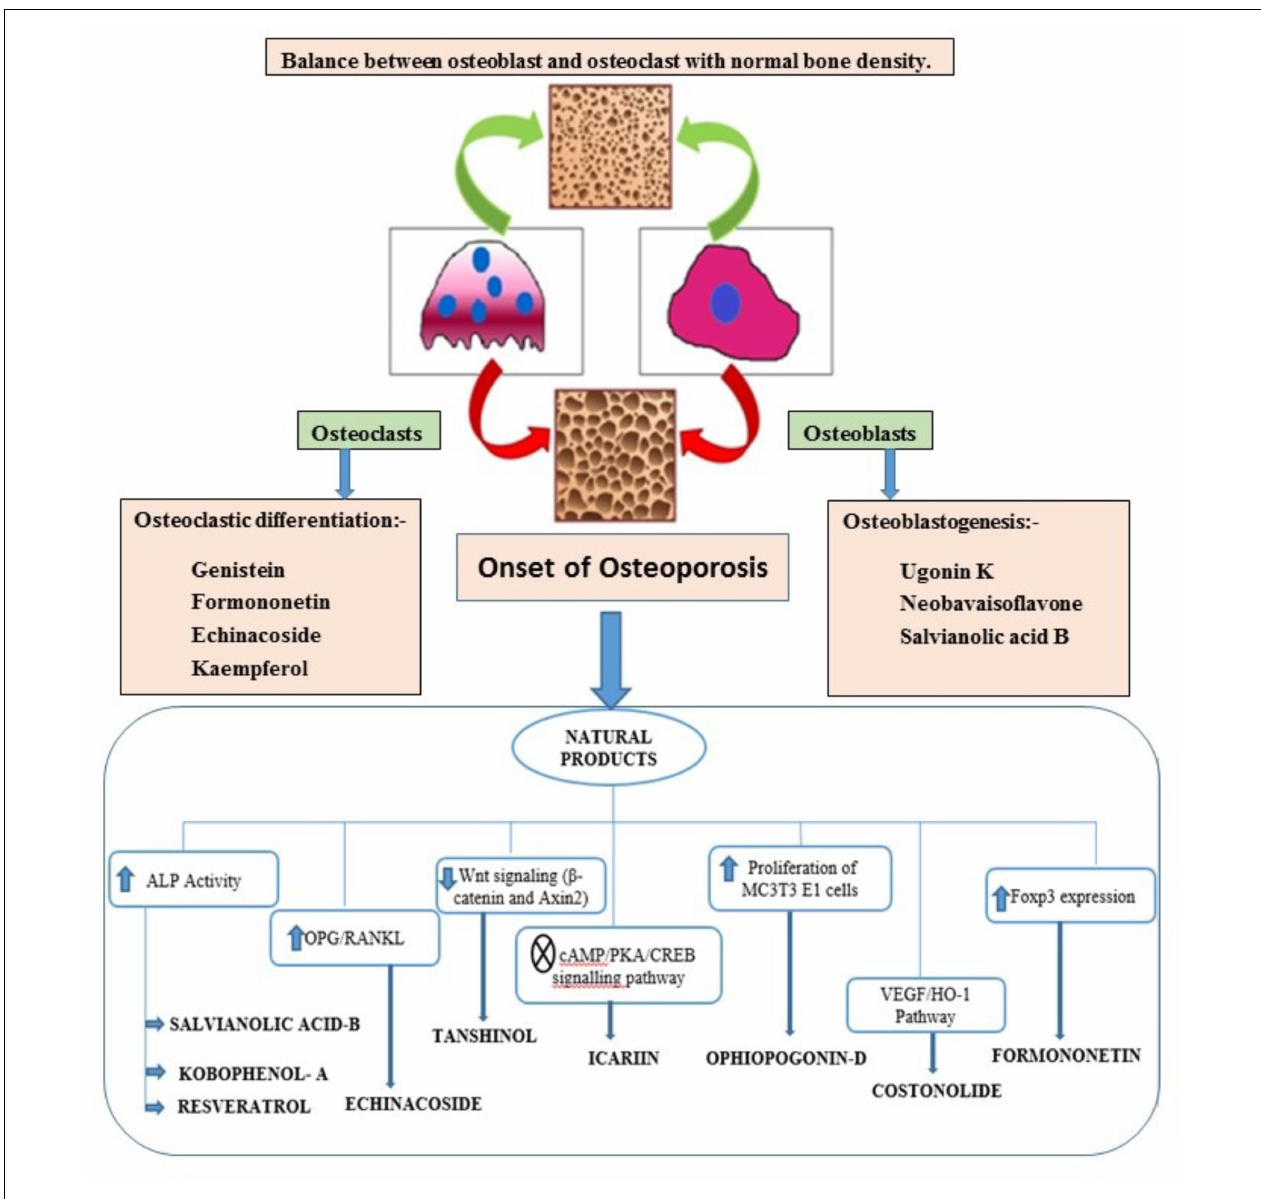
FIGURE 1 | Phytochemicals and their mechanisms intervening various pathways in osteoporosis.